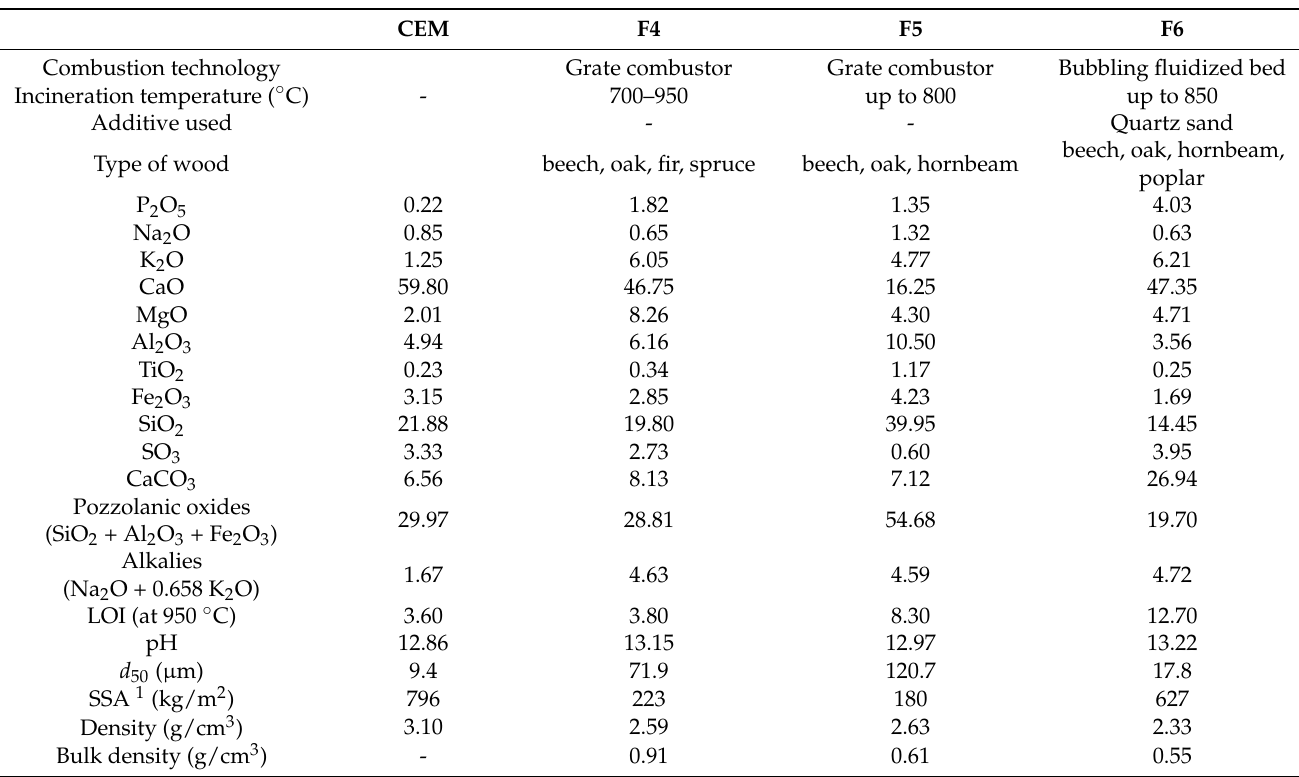
Table 1. Chemical and physical composition of cement and WFA [35].